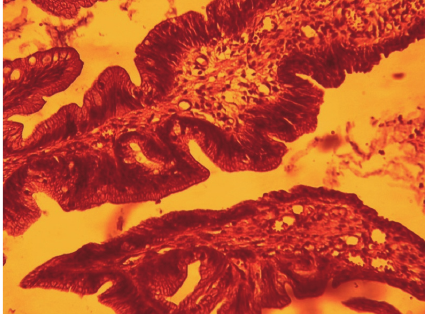
Figure 4: Villous adenoma (case